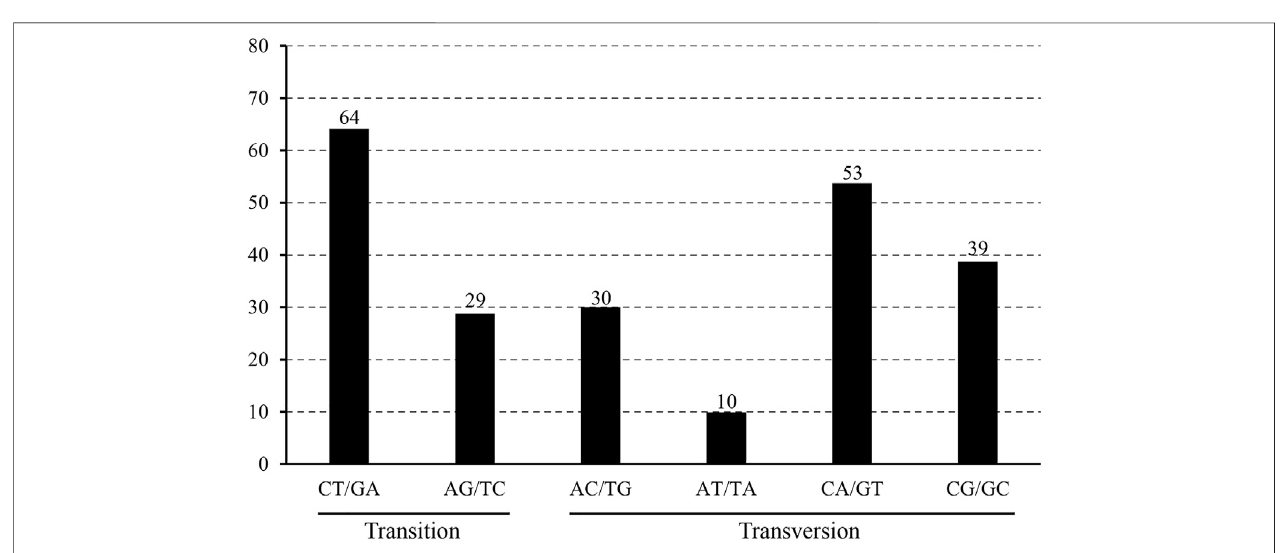
FIGURE 2 | The patterns of nucleotide substitution among the eight L. cardiaca haplotypes. Nucleotide substitution were divided into six types as indicated by the six non-strand-speci fi c base-substitution types (i.e., numbers of considered G to A and C to T sites for each respective set of associated mutation types).